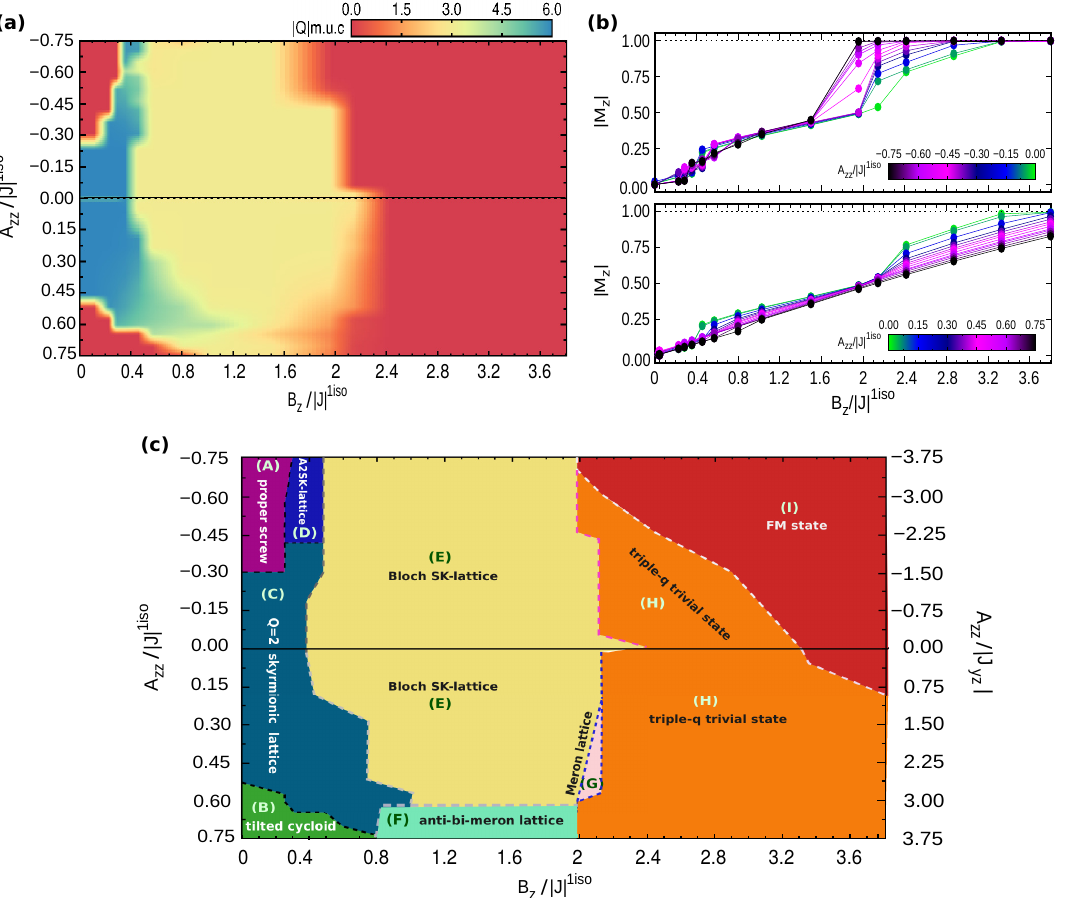
Figure 1. Single-ion anisotropy and field induced phase transitions. ( a ) Low temperature ( T = 1 K) phase diagram in the SIA-magnetic field A zz − B z parameters space; both A zz and B z are expressed in units of the nearest neighbour isotropic exchange interaction | J | 1 iso . Color-map indicates the absolute value of the topological charge per magnetic unit cell | Q | m . u . c . . ( b ) Evolution of the out-of-plane magnetization M z as a function of the magnetic field B z for increasing SIA, easy-axis ( A zz / | J | 1 iso < 0, top) and easy-plane ( A zz / | J | 1 iso > 0, bottom), respectively. ( c ) Schematic A zz − B z phase diagram identifying regions occupied by the different spin configurations, labelled with capital letters. Phase boundaries must be regarded only as semi-quantitative, as the field-induced topological phase transitions go through almost continuous transformations of the spin texture and metastable spin states with fractionalized topological charge, preventing the identification of accurate and sharp phase boundaries. On the right-side of the y -axis, A zz / | J yz | ratio is also reported. The horizontal solid line separates the easy-axis (above) and easy-plane (below) SIA